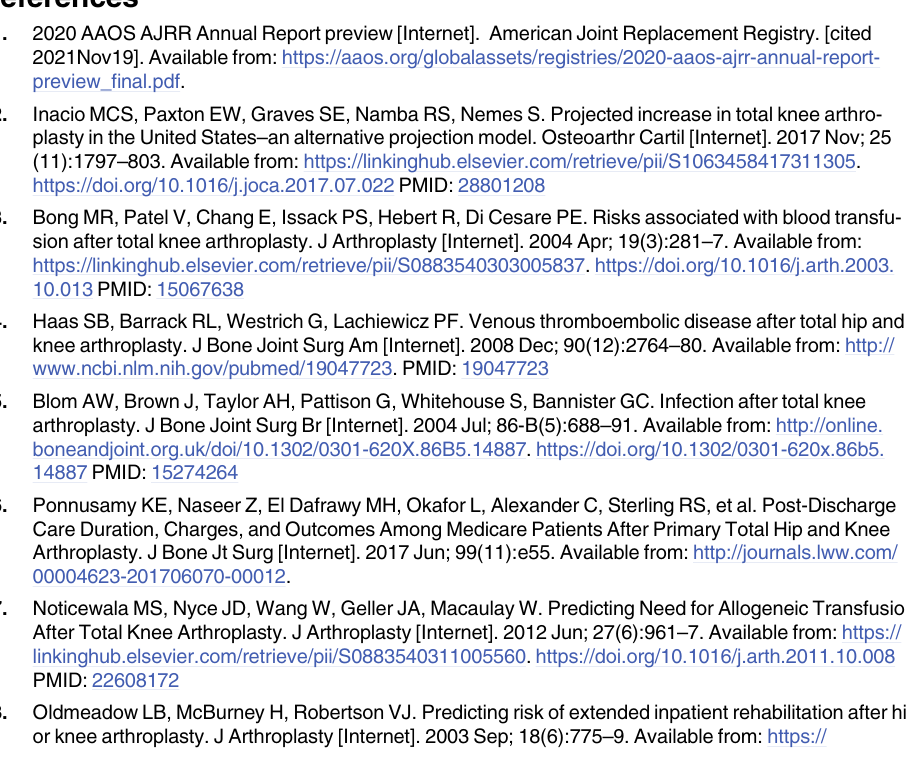
S2 Fig. An illustrative simple decision tree structure. S3 Fig. An illustrative 3-layer ANN structure. S4 Fig. Diagrammatic representation of the patient-level predictions obtained using the RF predictive